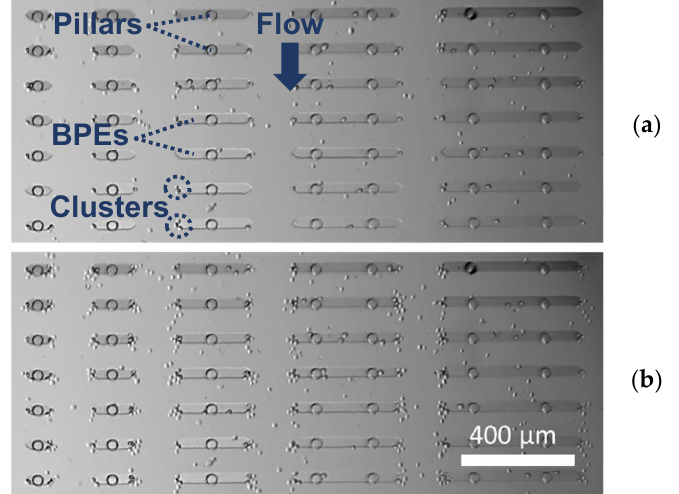
Figure 2. Brightfield micrographs of cells captured at the wireless BPE array. ∆ U tot = 26 V pp (70 kHz). Flow rate, 200 nL / min. Images were obtained ( a ) 1 min and ( b ) 5 min after initiation of ∆ U tot .